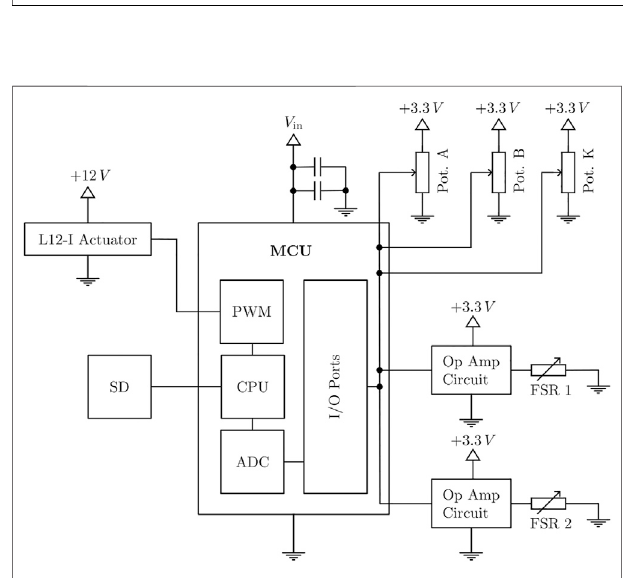
FIGURE 7 | Rendering (A) and application of the real system (B) of the exoskeleton. The rendering contains all the information about the exoskeleton and its components. In the bottom row, the exoskeleton is attached to the index fi nger of three individual test subjects.